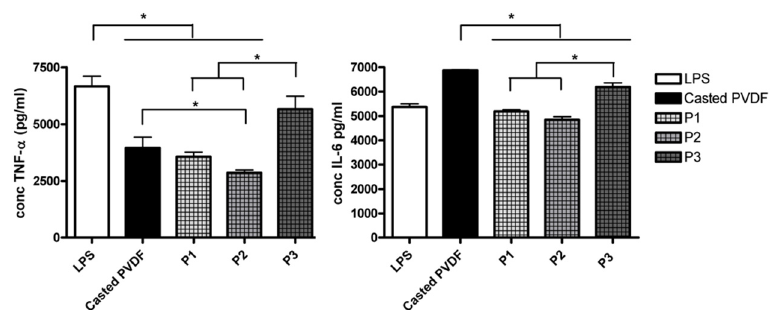
Figure 8. Secreted levels of pro-inflammatory cytokines TNF- α and IL-6 from THP-1 cell cultured on surface materials in lipopolysaccharide (LPS) treated condition. Data are presented as mean values ± SD, and significance was determined at * p < 0.05.